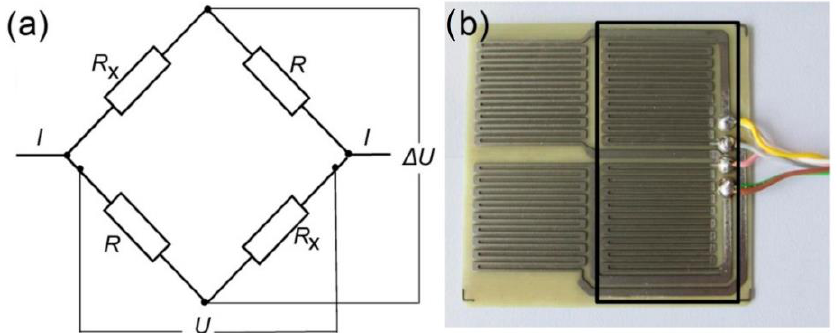
Figure 13. An ER sensor made of high-strength steel with four elements: ( a ) a schematic illustration of the sensor; ( b ) a photo of the sensor, protected by a transparent epoxy coating (reproduced with permission from Reference [24]).